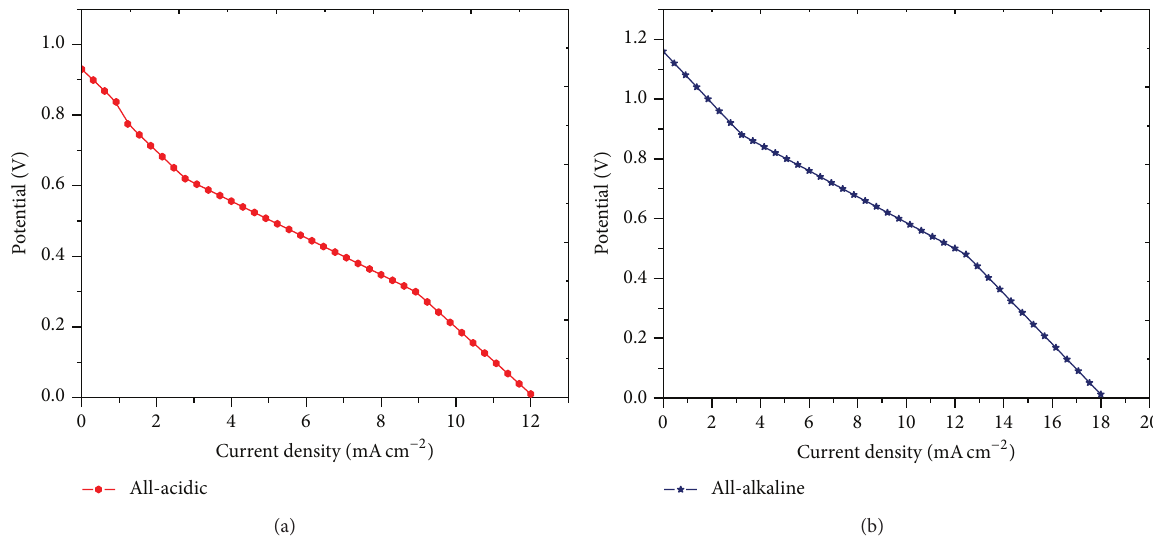
Figure 2: Polarisation curves for overall cell performance of MLSPBFC operating in (a) all-acidic and (b) all-alkaline media at room temperature. For both experiments the fuel stream is 2 M formic acid + 0.5 M NaOH (a) and in 0.5 M H 2 SO 4 (b) and the oxidant stream is 0.1M perborate + 0.5 M NaOH (a) and 0.5 M H 2 SO 4 (b). Stream flow rates: 0.3 mLmin −1